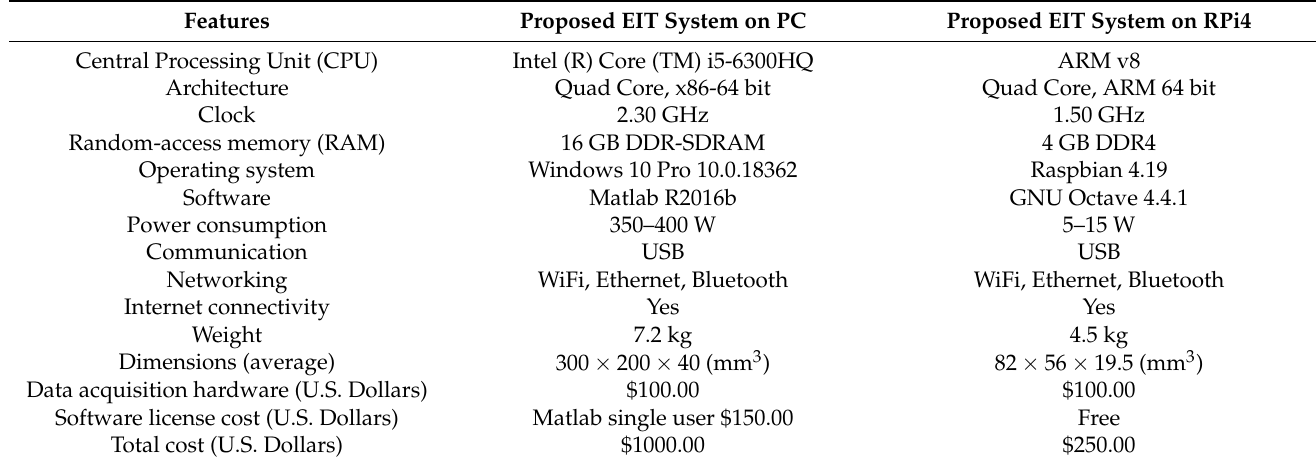
Table 3. Comparison of characteristics of the proposed EIT on the PC versus RPi4.